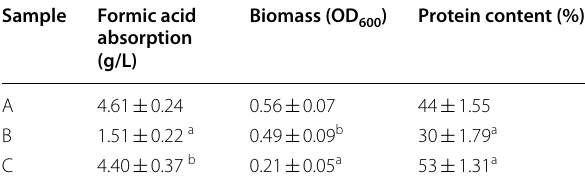
Table 1 Physiological parameter detection of strain MA5 under different culture